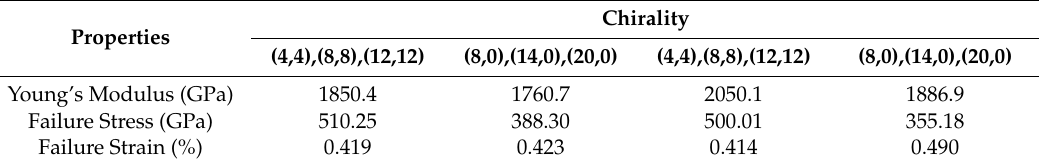
Figure 8. Schematic cross-sectional view of: ( a ) zigzag and ( b ) armchair TWC 3 NNTs. Table 6. Mechanical properties of zigzag and armchair TWC 3 NNTs and TWCNTs under uniaxial tensile tests at 300